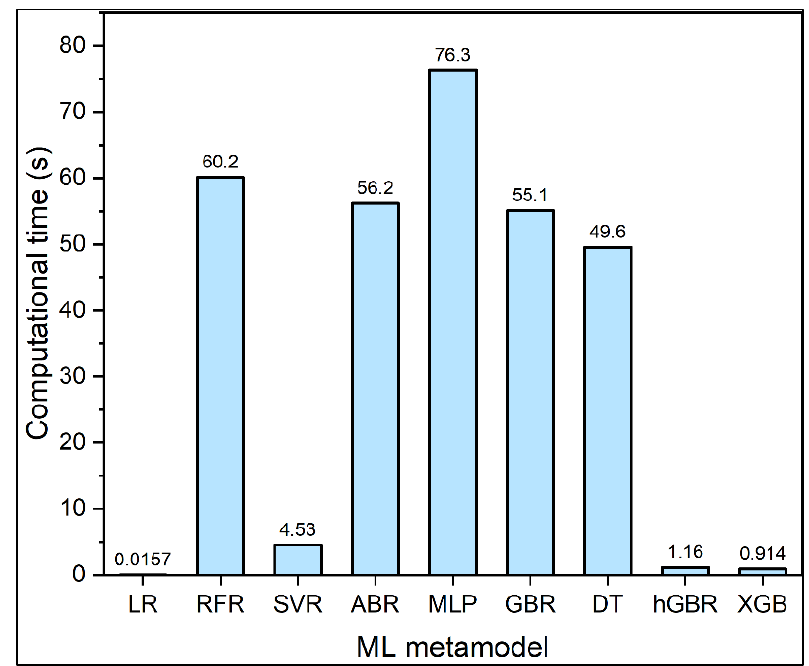
Figure 8. Computational time of each ML